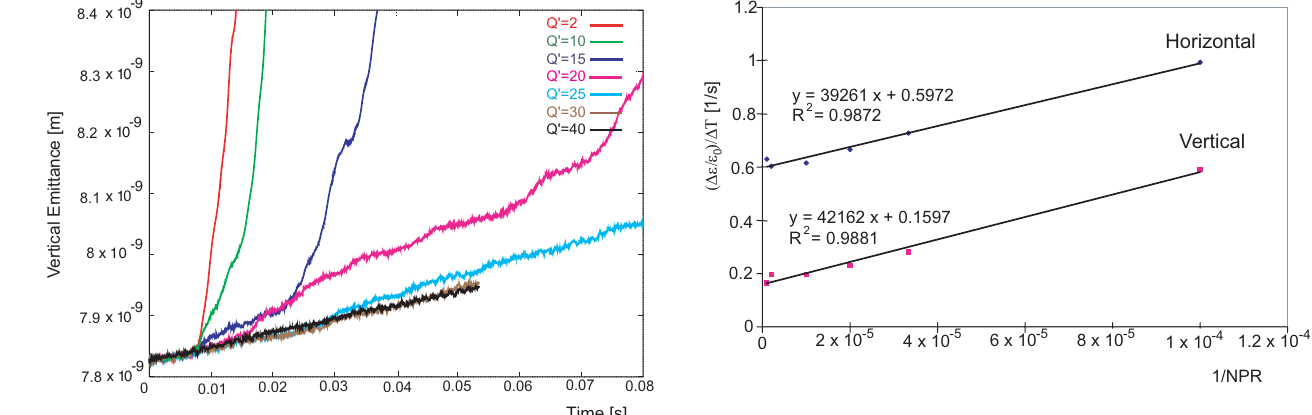
FIG. 12. (Color) Horizontal and vertical emittance-growth rate as a function of the inverse of the number of macroprotons ( 1 = NPR ), in the ‘‘slow’’ emittance-growth regime; the electron- (cid:2) 6 (cid:6) 10 11 m (cid:4) 3 and the chromaticity Q 0 (cid:2) cloud density is (cid:2) e 40 .